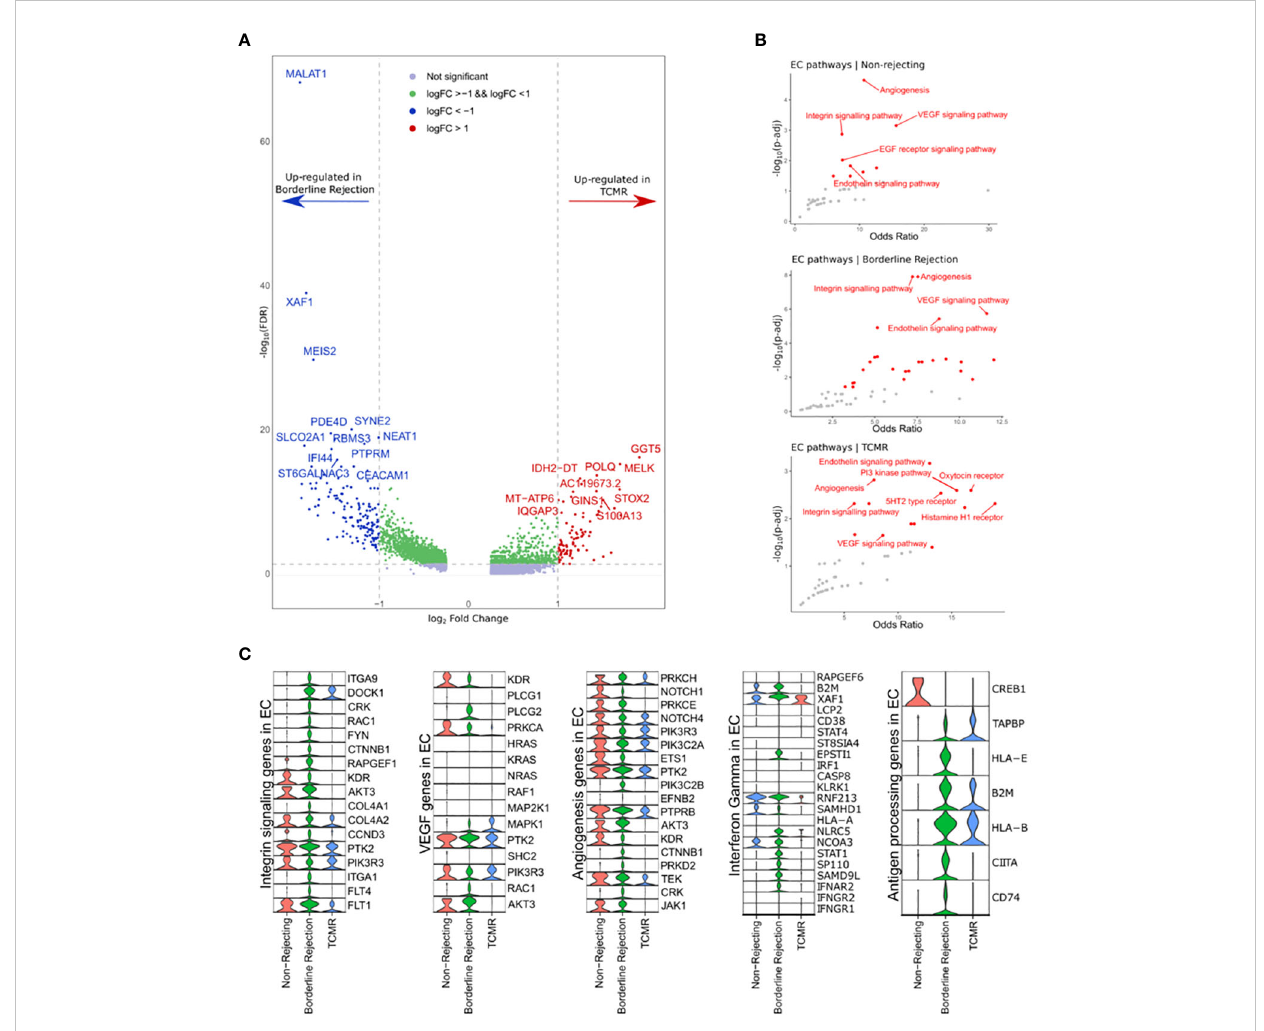
FIGURE 3 (A) Volcano plot showing the up-regulated genes in endothelial cell clusters (ECs) between borderline and TCMR. Blue and red dots and genes up- regulated in borderline and TCMR, respectively; green dots are genes with log-fold change (logFC) between 1 and -1; gray dots are genes that did not reach a signi fi cance level. (B) Scatter plots showing the top enriched pathways in non-rejection, borderline, and TCMR samples. (C) Violin plots showing the level expression of genes part of integrin signaling, VEGF, angiogenesis, interferon-gamma response, and antigen processing pathways in ECs clusters in the three